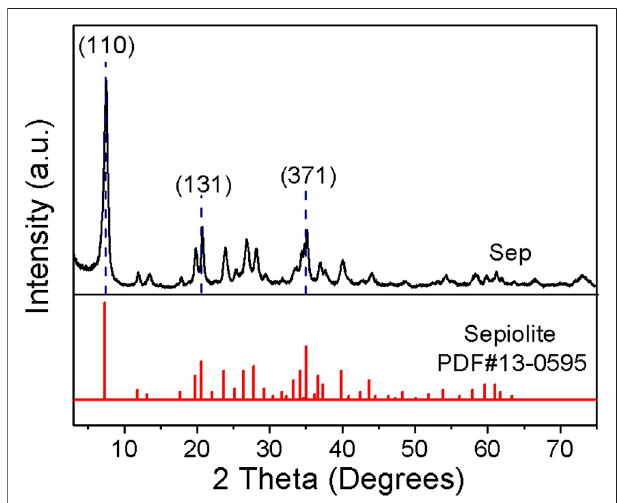
FIGURE 1 | XRD pattern of